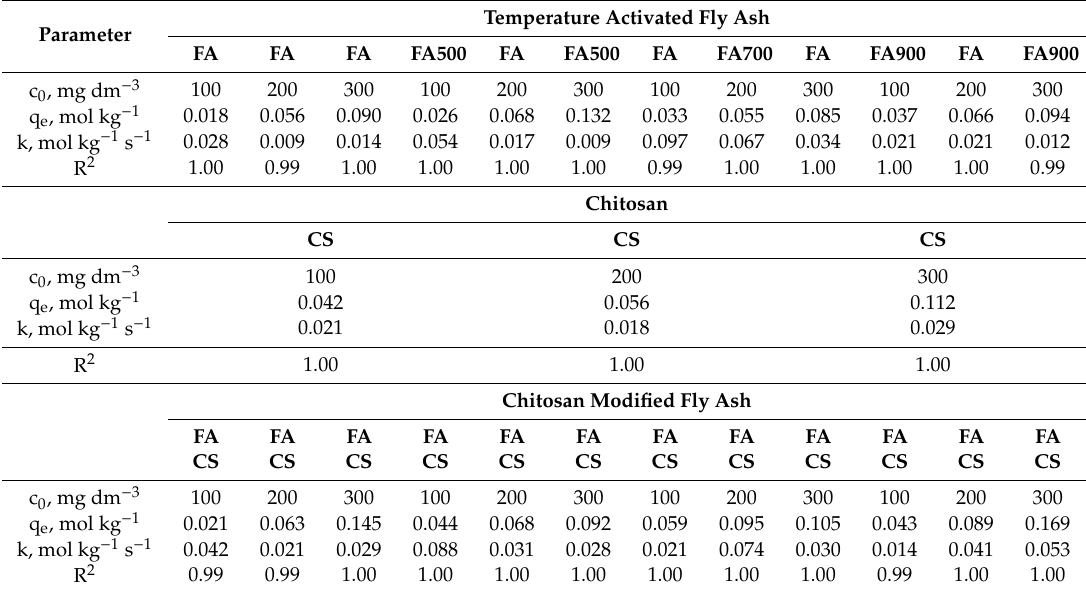
Table 7. Pseudo-second order kinetic parameters for As(V) adsorption on the studied adsorbents. Abbreviations: c 0 —initial As(V) concentration, q e —equilibrium adsorption for a given c 0 , k—kinetic constant for a given c 0 , R 2 —correlation coe ffi cient of experimental points fit to linear form of pseudo-second order (PSO) equation.